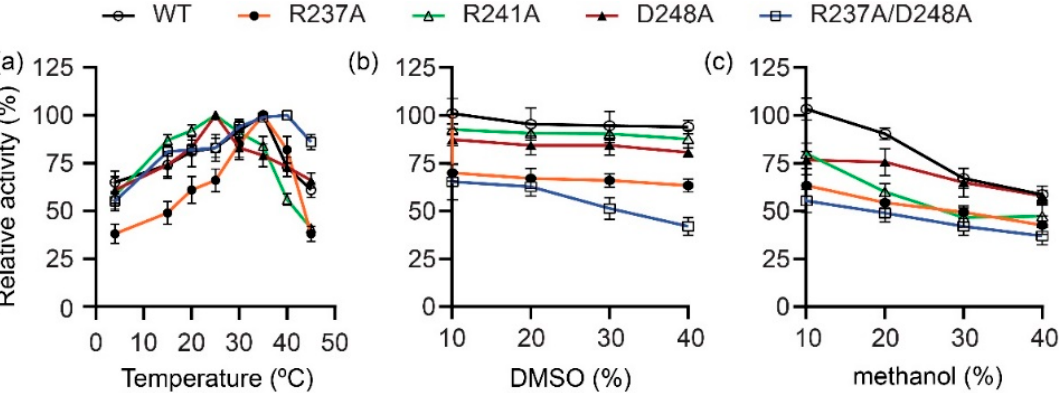
Figure 3. Effects of temperature and organic solvent on the enzymatic activity of WT and mutant PML enzymes. ( a ) Optimum temperature. ( b ) PML activity in 10–40% DMSO. ( c ) PML activity in 10–40% methanol. Data presented correspond to the mean ± SD of three experiments.